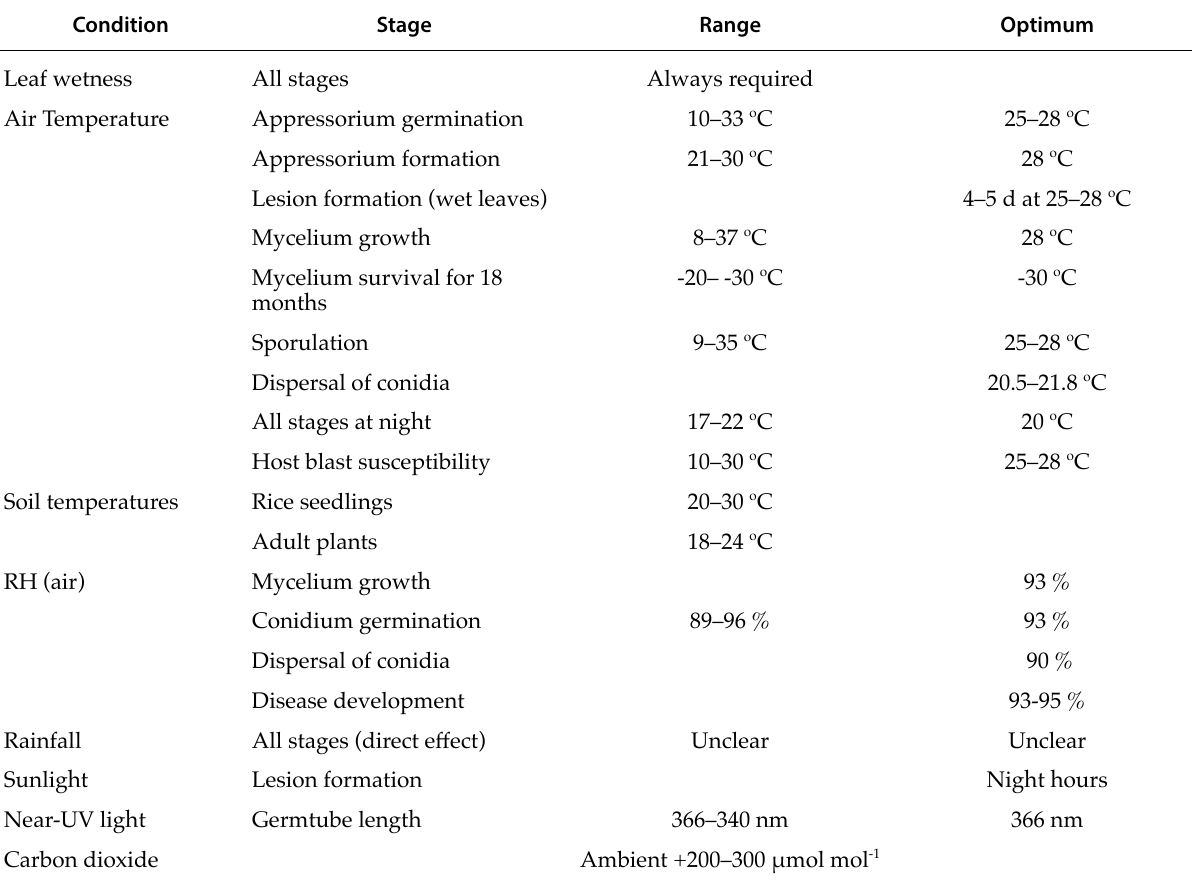
Table 1. Range and optimum environmental conditions which favour rice blast development, as reported in the